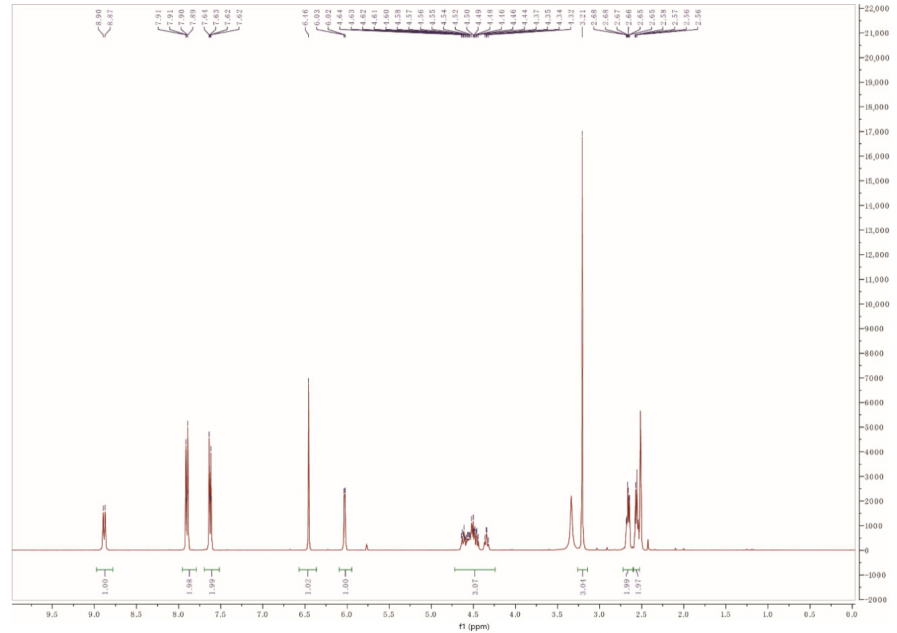
Figure 2. 1 H Nuclear Magnetic Resonance (NMR) characterization of Flo-COOH, the spectra were recorded at 298 K on a Bruker-500 NMR spectrometer. DMSO-d6 (2.5 ppm and 3.3 ppm) was used